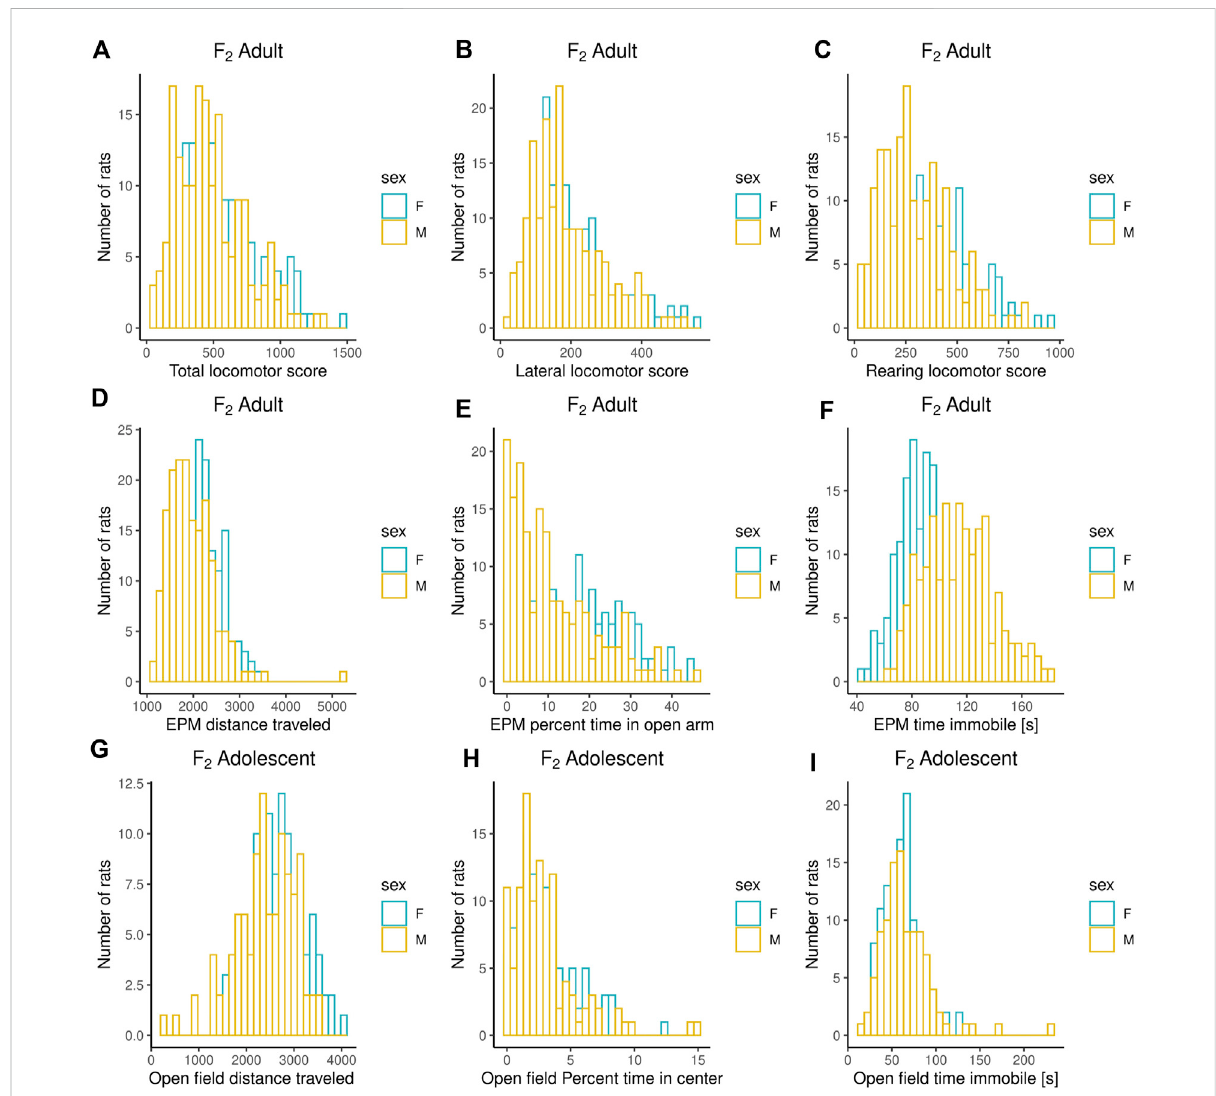
FIGURE 1 Frequency histograms showing the distribution of Locomotor Response to a Novel Environment, EPM, and OF traits in F 2 males and females prior to quantile normalization of the data. (A – C) Measures from Locomotor Response to a Novel Environment test: lateral, rearing, and